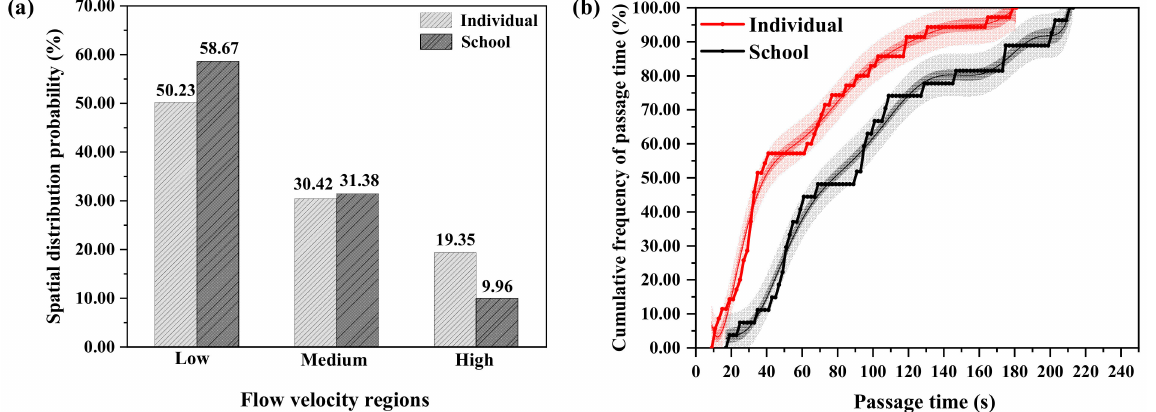
Figure 9. Spatial distribution probability and passage time: ( a ) Spatial distribution probability of S. prenanti individual and schooling in different flow velocity regions; ( b ) cumulative frequency of the passage time of S. prenanti individuals and